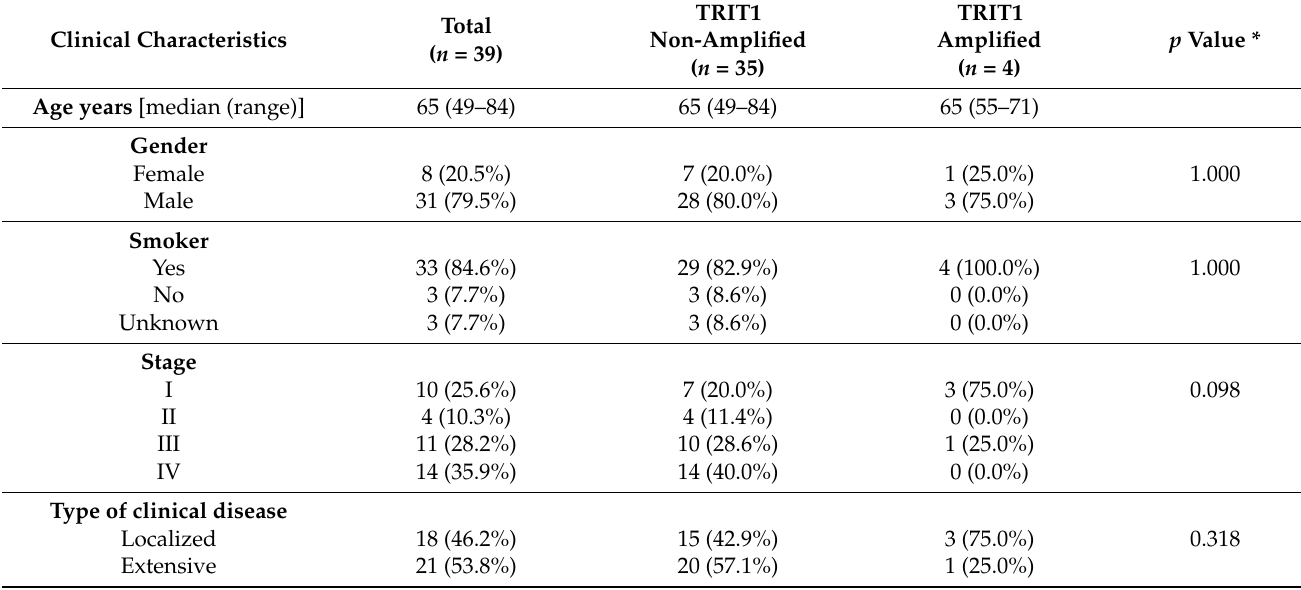
Table 1. Clinicopathological features of the studied small cell lung cancer patients according to TRIT1 gene amplification status.